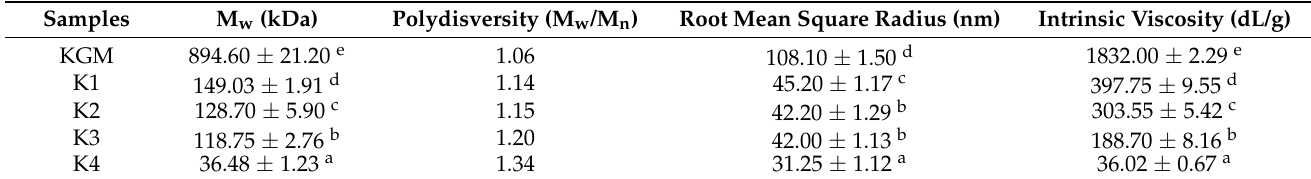
Table 1. The molecular characteristics of